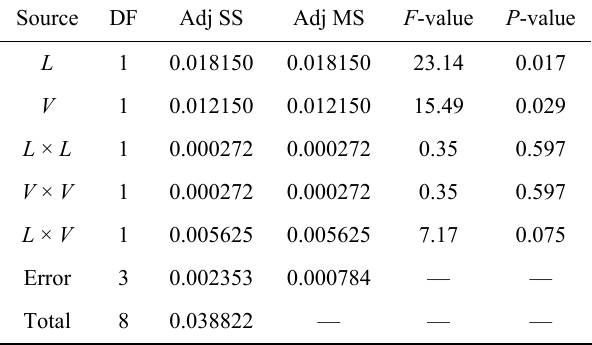
Table 5 Analysis of variance for f .